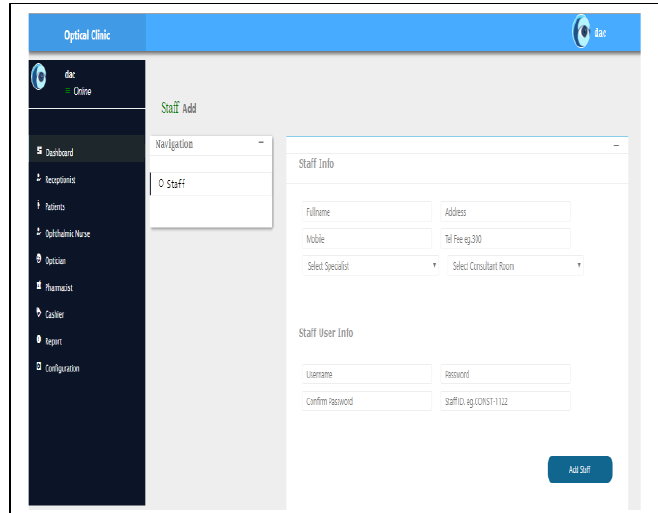
Figure 18. Staff